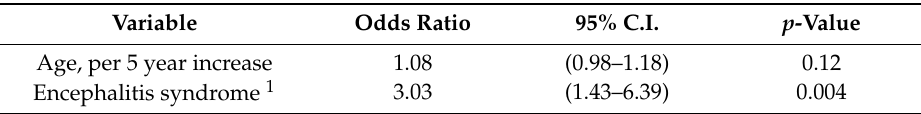
Table 6. Multivariable logistic regression model of